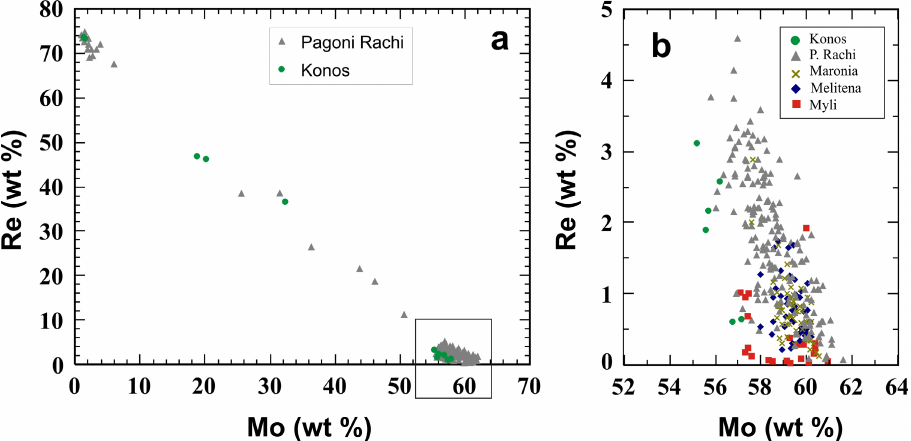
Figure 6. Re content of molybdenite, rheniite and intermediate molybdenite–rheniite phases from northeastern Greece (modified after [13,14] and new data). ( b ) is the inset shown in ( a ).